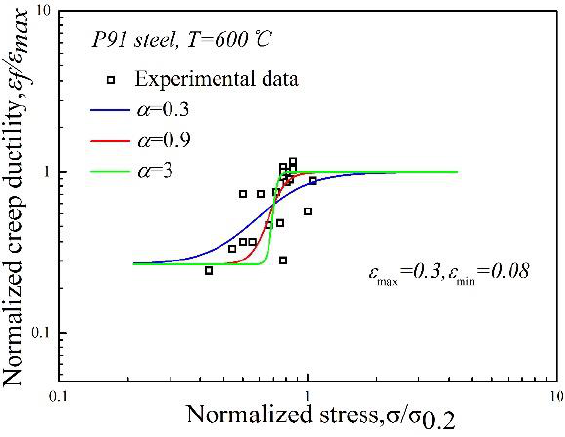
Figure 7. Different parameter α in the creep ductility model [34].